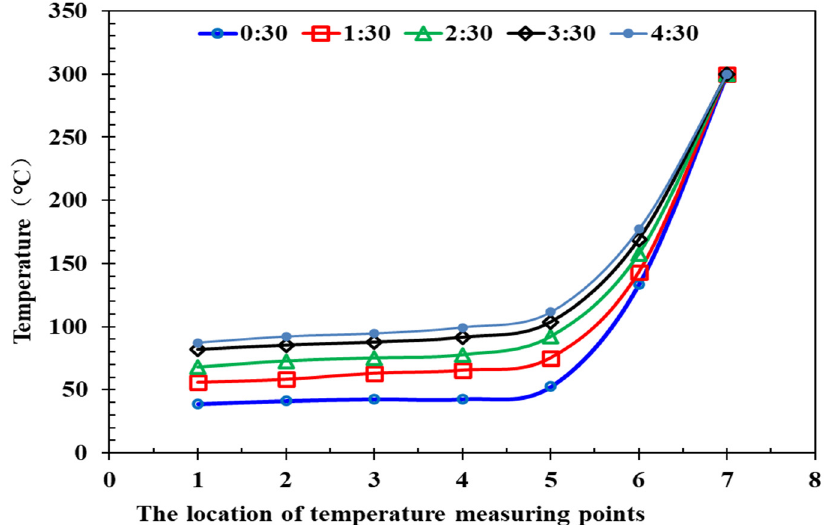
Figure 2. The heat transfer characteristics of model when injecting CO 2.